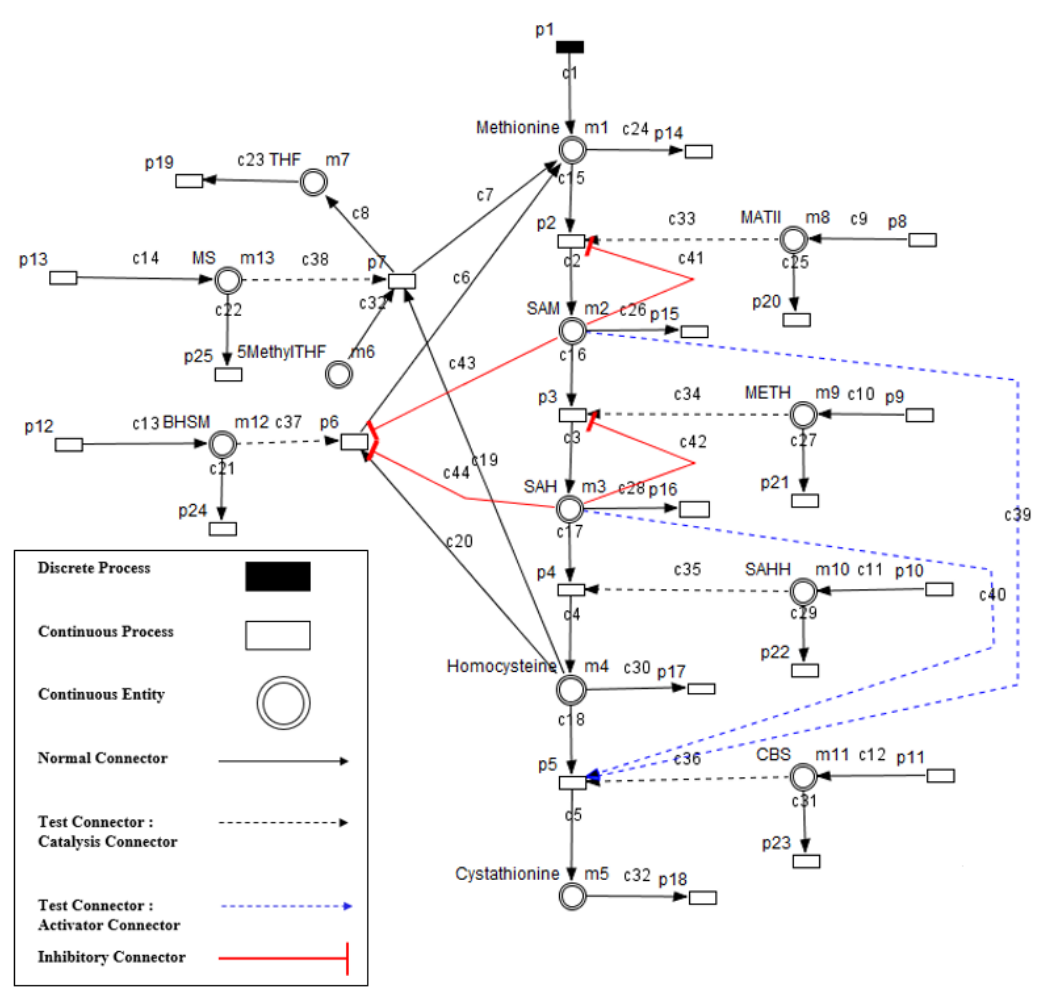
Figure 7. HFPN representation of the studied metabolic